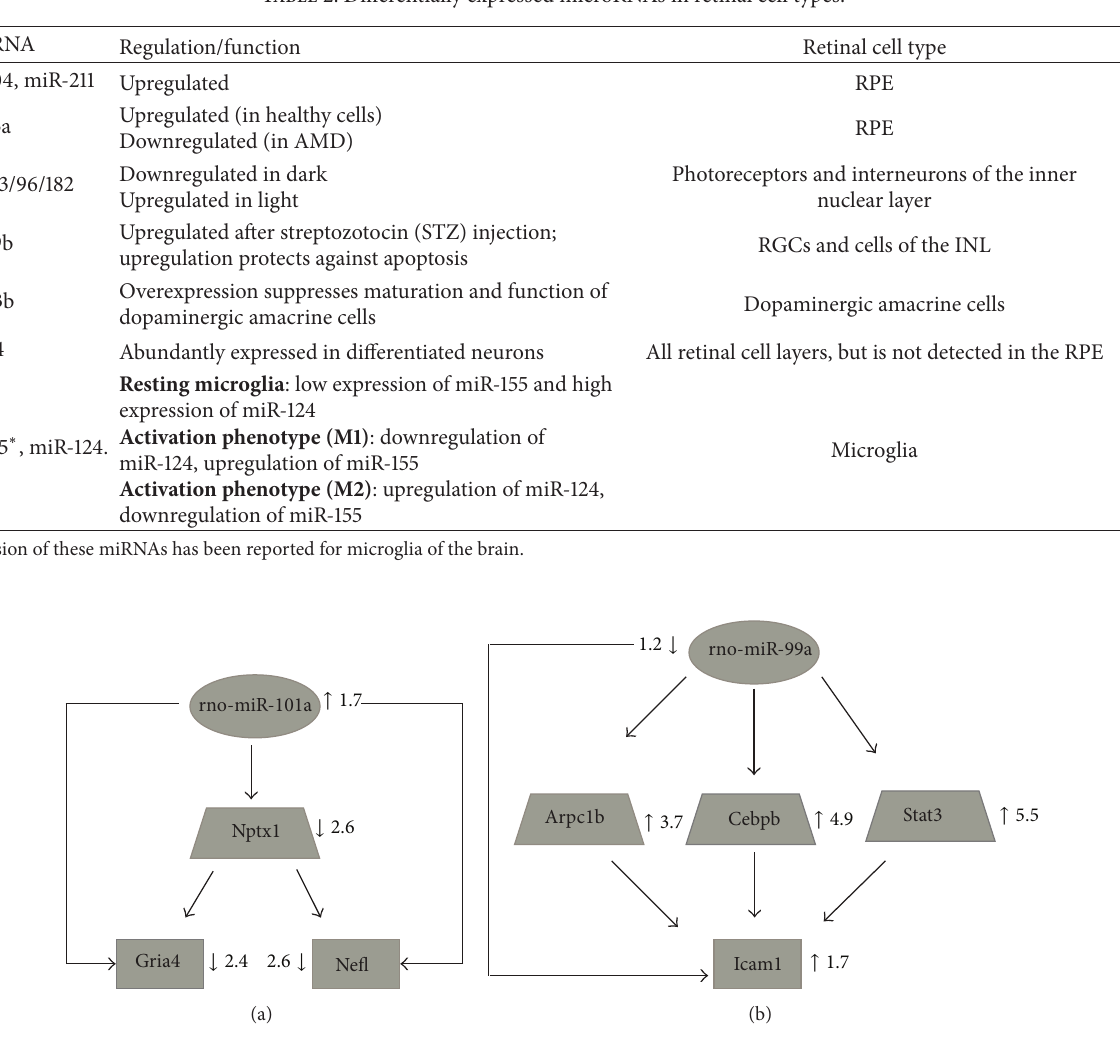
Figure 1: Two examples of mixed regulatory circuits, each containing a miRNA (oblate spheroid), linked to TFs (trapezoids) and coding gene targets (rectangles), all of which changed their expression in response to transient ischemia-reperfusion injury in the retina. The numbers and bold arrows represent fold change relative to sham control animals and up- /downregulation (resp.) of the miRNAs, TFs, and protein coding genes implicated in the mixed regulatory circuits. (a) Direct and indirect downregulation of two coding genes by the same miRNA (rno- miR-101a). At 24h IR period, rno-miR-101a targets the protein coding genes Gria4 (glutamate receptor) and Nefl (neurofilament) directly. At the same time, rno-miR-101a can control these genes indirectly by targeting the TF Nptx1, which in turn targets Gria4 and Nefl. (b) miRNA targets several TFs which act together to coordinate the reduced expression of a single gene. At 24 h IR period, rno-miR-99a targets the protein coding gene Icam1 (adhesion molecule) directly. At the same time, rno-miR-99a can control this gene indirectly by targeting 3TFs (Arpc1b, Cebpb, and Stat3), which in turn target